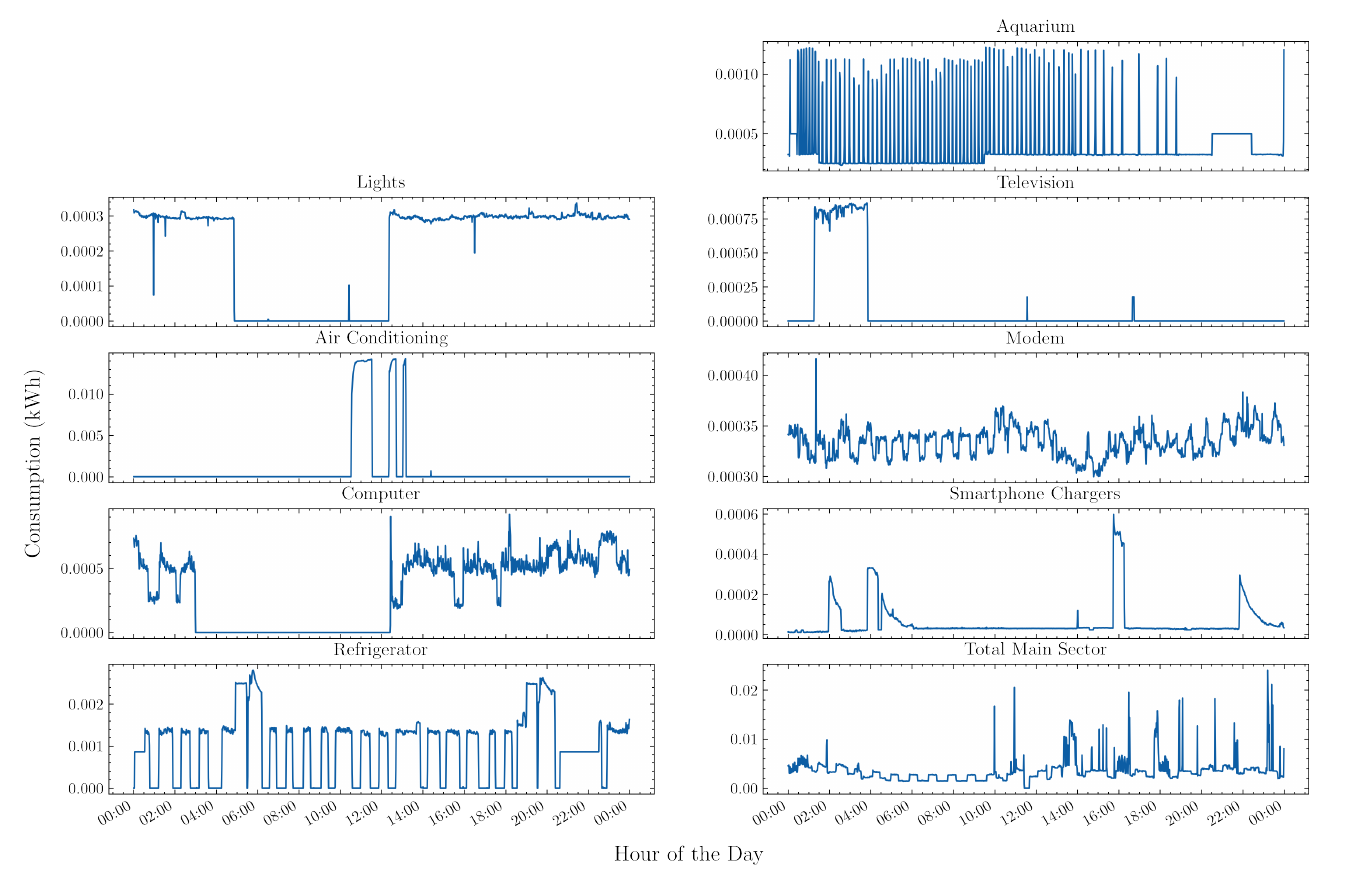
Figure 2. Daily load profile of different appliances during a weekday.